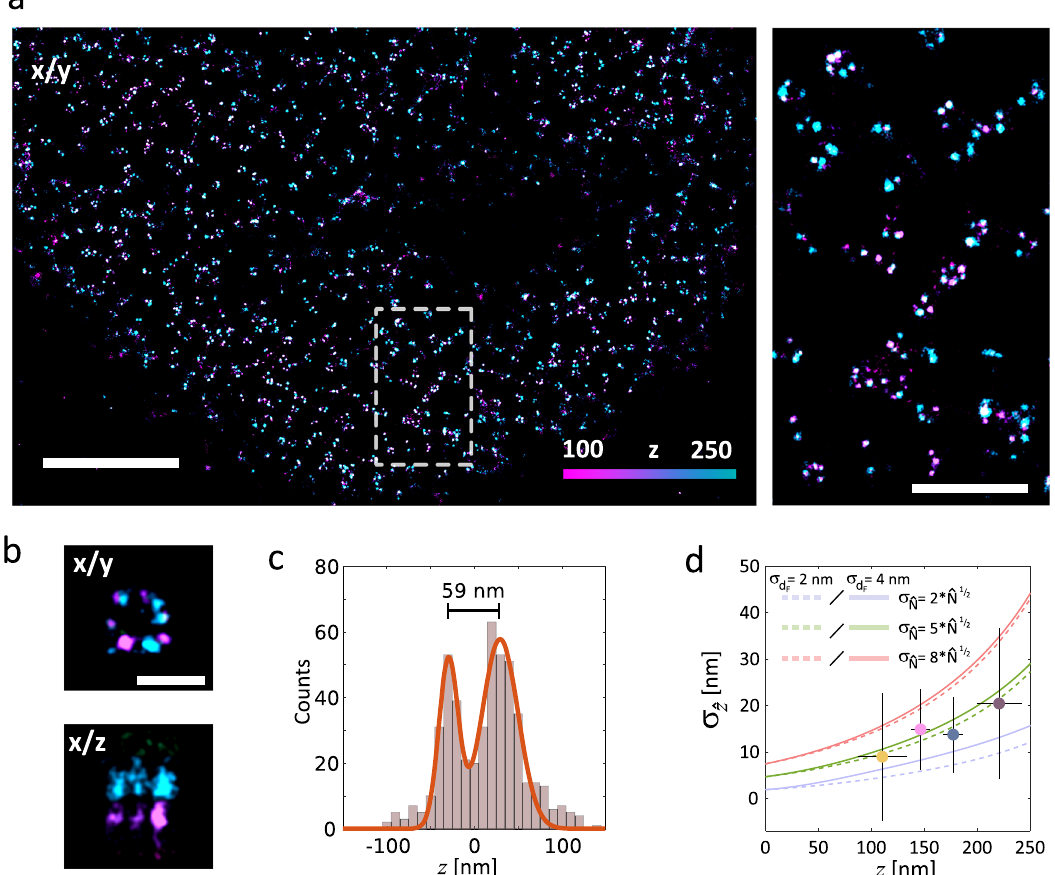
Fig. 4 NUP107 immunolabeled for dSTORM and super-resolved in 3D using SIMPLER. a Left: top view of dSTORM image of NUP107-mEGFP in HeLa Kyoto cells, labelled with primary anti-GFP antibody conjugated to Alexa Fluor 647. Right: magni fi ed view of the region marked. Four independent experiments were performed with similar results. b Average nuclear pore complex showing the archetypal eightfold symmetry ( xy top-view, top) and the organization in nuclear and cytoplasmic rings ( xz side-view, bottom) reconstructed by SIMPLER ( n = 4). Top- and side-views have the same z -colour scale as de fi ned in a . c Histogram of z -positions of the nuclear pore complex shown in b yields 59-nm separation between the nuclear and cytoplasmic rings. d Median σ ^ z values of different z -positions obtained experimentally from 161 dSTORM single-molecule traces overlapped with theoretical curves of σ z for ffiffiffiffi p ^ N ^ N = 10,000 and σ ^ = 2 x , 5 x or 8 x for σ dF = 2 and 4 nm. Error bars represent the standard deviation of σ ^ z and z . The number of single-molecule traces N 0 analysed in each interval was 59 (for z = 35 – 130 nm); 45 (for z = 130 – 160 nm); 30 (for z = 160 – 190 nm) and 23 (for z = 190 – 250 nm). Data include localizations from four biologically independent samples (four HeLa Kyoto cells from independently prepared samples). Scale bars represent 2 µ m ( a , left); 500 nm ( b ) and 100 nm ( c ). Number of localizations kept after frame- fi ltering step: b 1101 (out of